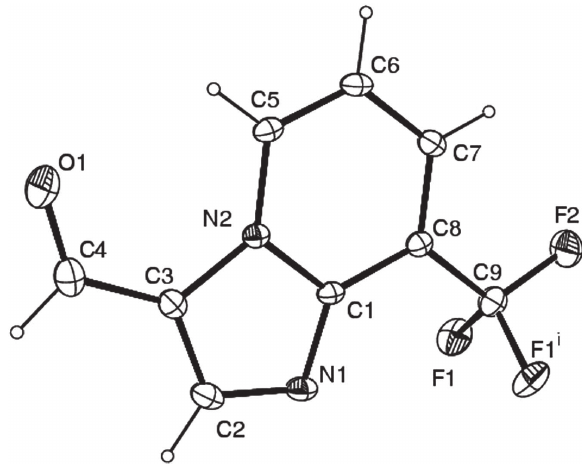
Table 2: Fractional atomic coordinates and isotropic or equivalent isotropic displacement parameters (Å 2